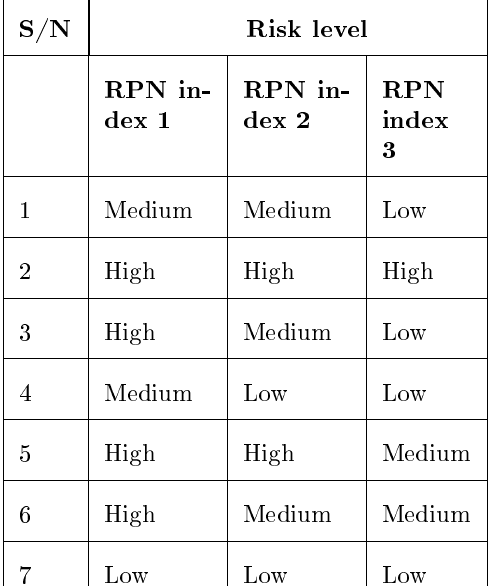
Tab. 12: Failure modes risk level.